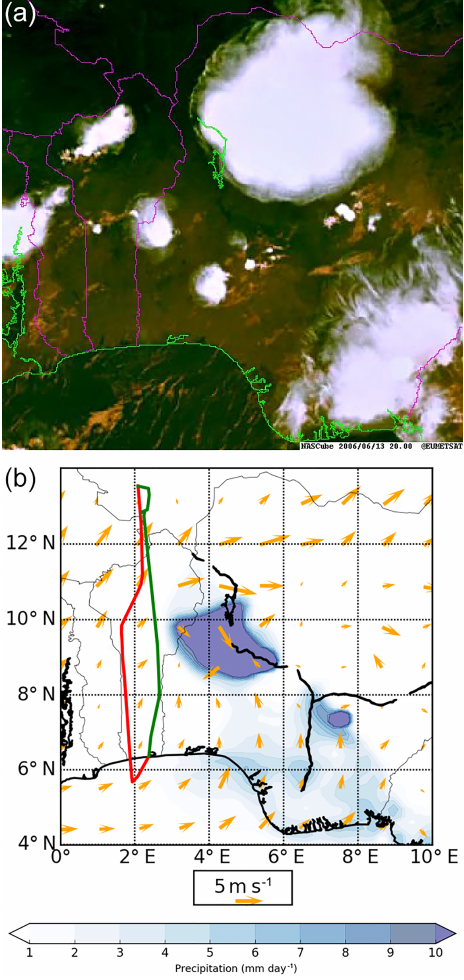
Figure 4. (a) EUMETSAT visible image of the Cotonou area of 13 June 2006 at 20:00UTC (from NAScube http://nascube.univ-lille1. fr); (b) map of the Cotonou area for 13 June 2006 at 12:00UTC with wind vectors at 10m (orange arrows) and precipitation (blue shading). The two flight trajectories are displayed with the red line for 13 June and with the green line for 14 June.